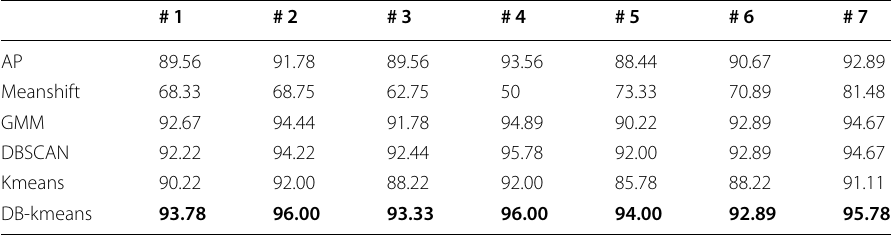
Table 3 Accuracy of each cluster # 1